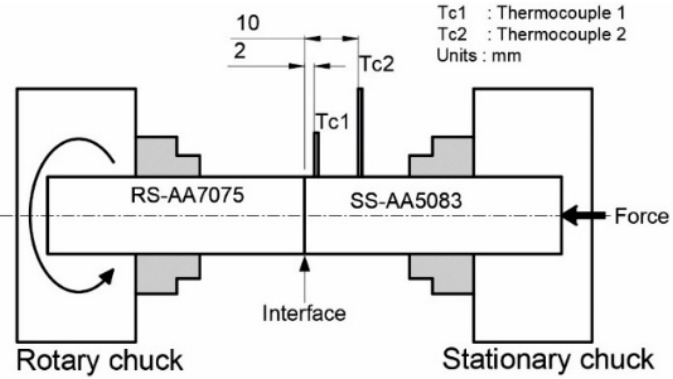
Figure 2. Principle setup for rotary friction welding.